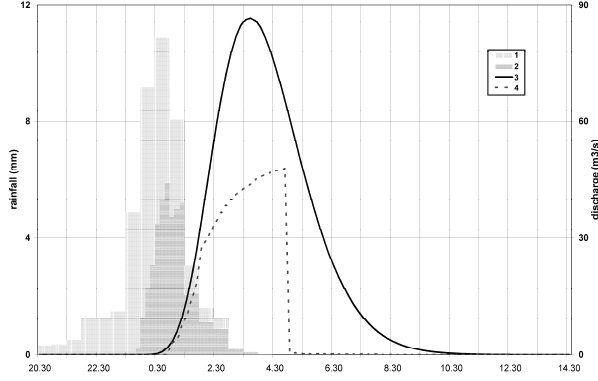
Figure 5 - Rainfall and flood of the 2005 event in the selected catchment. 1) Actual and 2) net 3 Fig. 5. Rainfall and flood of the 2005 event in the selected catch- rainfall (portion of rainfall available for runoff), 3) flood discharge at the catchment bottom, 4 ment. (1) Actual and (2) net rainfall (portion of rainfall available 4) culvert outflow. 5 for runoff), (3) flood discharge at the catchment bottom, (4) culvert 6